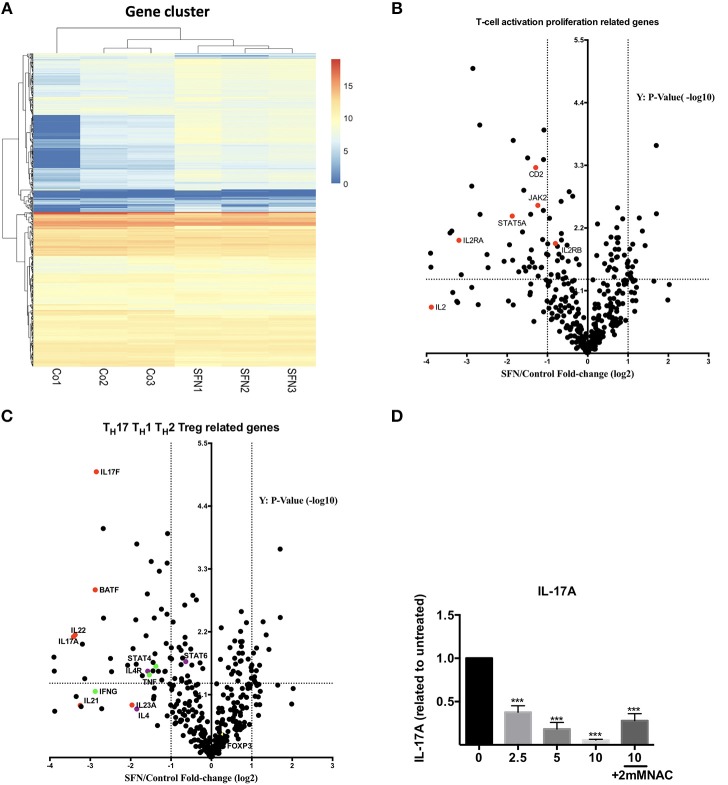
Gene expression analysis (nCounter®). (A) Hierarchical clustering of differentially expressed mRNAs in untreated (Co, n = 3) and SFN treated (SFN, n = 3) T-cells of three different donors. Each column represents an individual sample. Relative fold change is indicated by the color scale (red: high; blue: low). (B,C) Volcano plots show the differentially expressed genes important for T-cell activation and proliferation (B) and related to TH1, TH2, Treg, and TH17 cells (C). Log2 transformed fold change in expression (SFN vs. control) on the x-axis is plotted against significance (–log10 adjusted p-value) on the y-axis. The horizontal dashed lines indicate cutoff for significance p < 0.05 (–log10 p-value >1.3) and the vertical lines for fold change ≥2/≤-2. (D) Quantification of IL-17A in the supernatant of T-cells co-stimulated with anti-CD3 (20 ng/ml)//CD28 (5 μg/ml) antibodies for 2 days in the absence/presence of SFN, with or without NAC supplementary treatment as indicated. IL-17A was measured by a human TH cytokine panel (n = 3; mean; SE; *p < 0.05 ***p < 0.001).